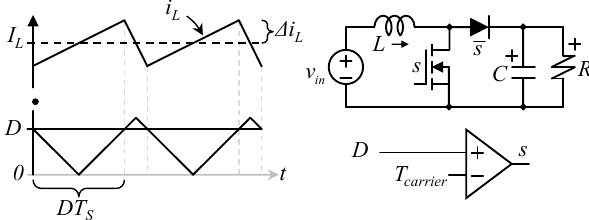
Figure 1. The traditional boost converter, and important waveforms related to the input current ripple.